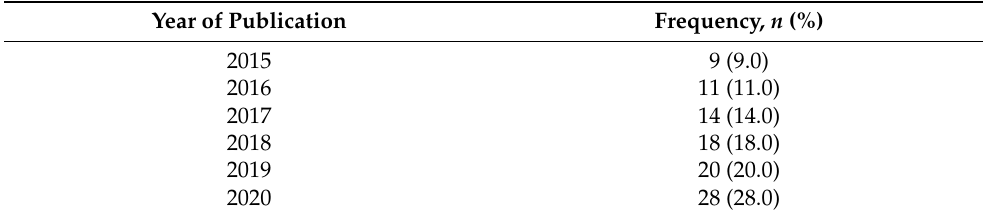
Table 2. Year of publication of the 100 videos.